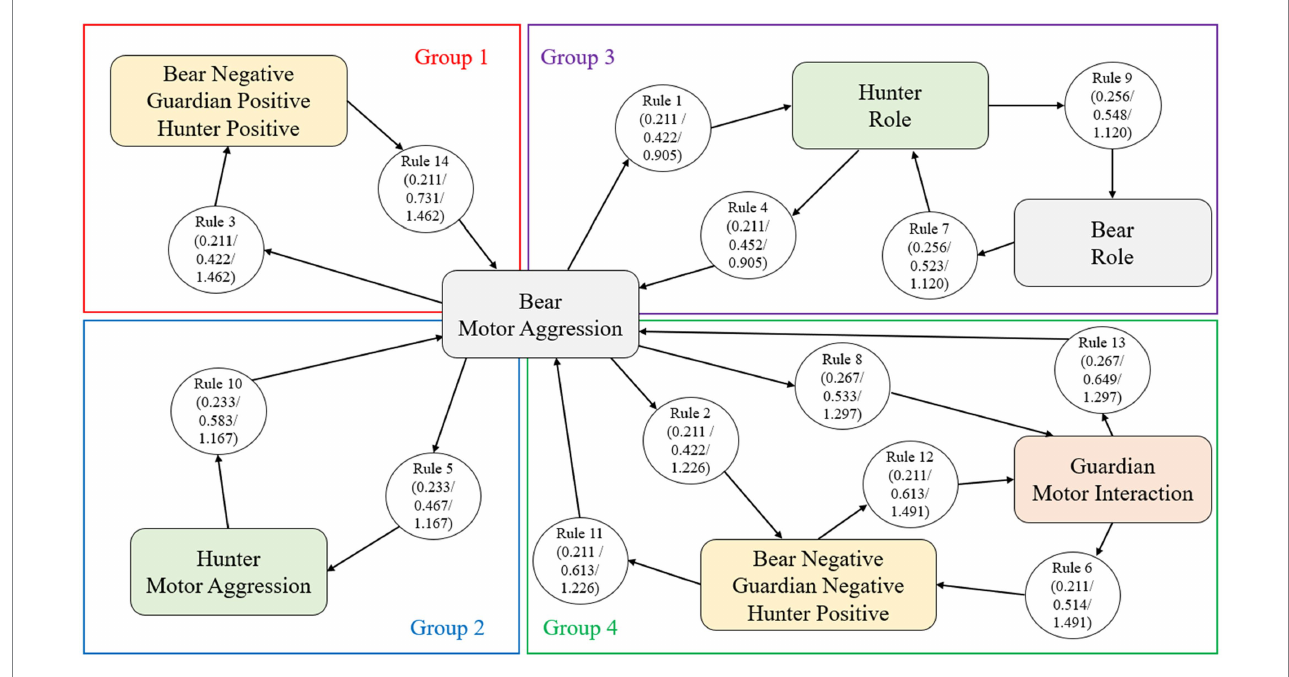
FIGURE 11 Emotional itineraries (groups of association rules) based on the emotional meaning of the Bear associated with Motor Aggression by support, confidence and lift